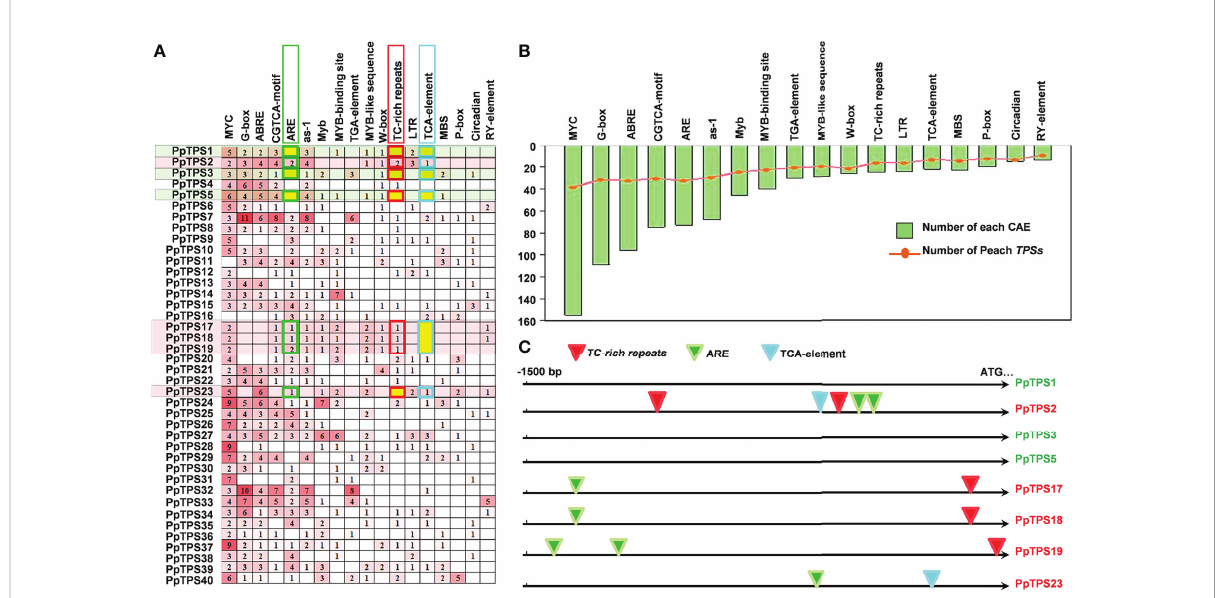
FIGURE 8 Distribution of cis -acting regulatory elements in the promoter of PpTPS genes. (A) A heatmap shows the number of different cis -acting regulatory elements in the promoter of forty PpTPSs. (B) A bar graph shows the total number of each cis -acting regulatory element identi fi ed in the promoter of forty PpTPSs . The curve point denotes the number of PpTPSs having each cis -acting regulatory element. (C) A schematic shows the distribution of three SA-associated cis -acting regulatory elements in the promoters of eight selected PpTPSs